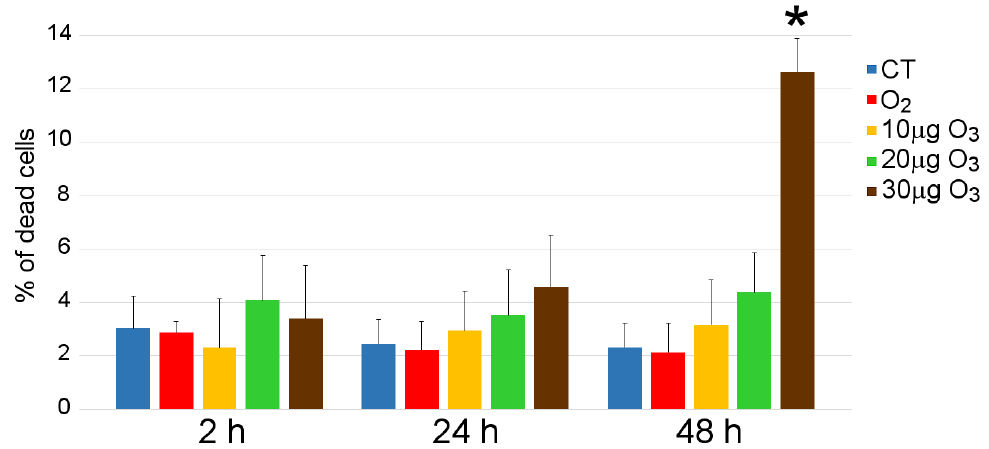
Figure 1. Diagrams show the mean value ± SD of percentage of dead cells in the samples after 2 h, 24 h, and 48 h from gas treatment. The asterisk (*) indicates significant difference with the respective control (CT).